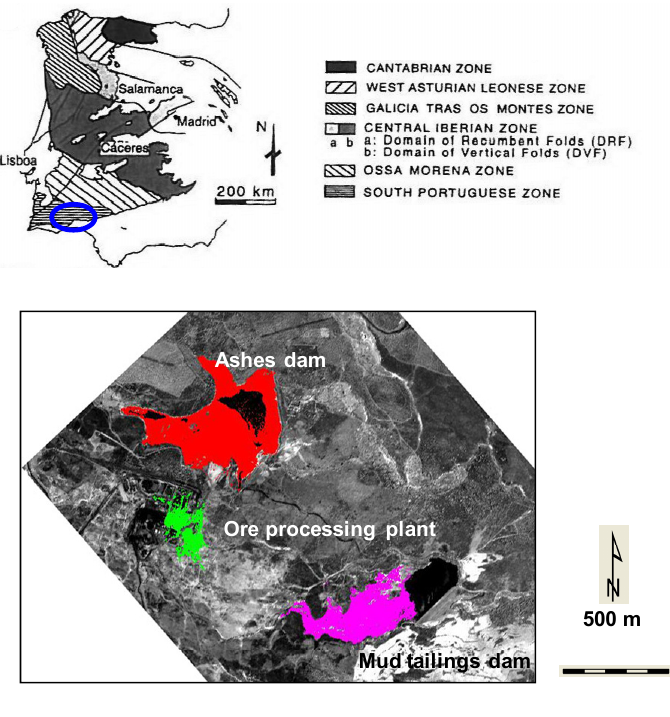
Figure 1. The location of the study area in the Iberian Hesperian Massif (Spain and Portugal) (blue circle) [17]. The location of domains within the Sotiel mine